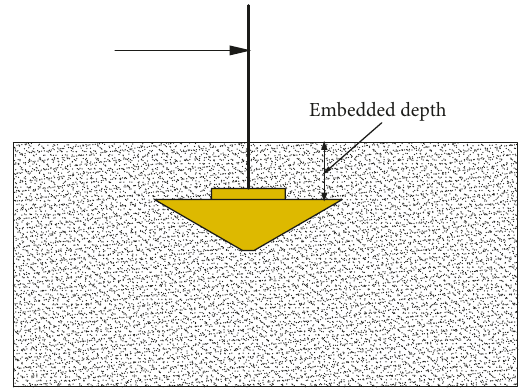
Figure 17: Schematic of embedded depth of the cone-shaped foundation model.